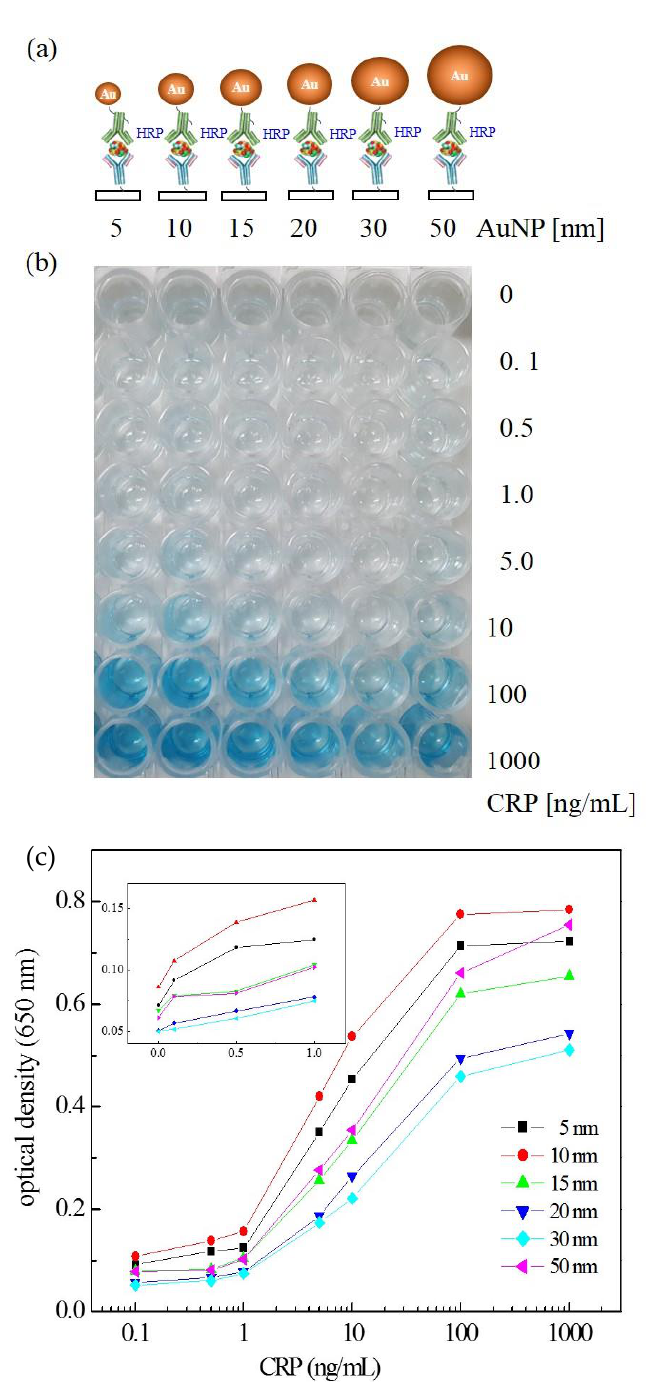
Figure 1. ( a ) The schematic view of the sandwich ELISA using AuNP • antiCRP-HRP with varying diameters of the AuNPs involved, ( b ) the picture of 96-well plate of the resulting ELISA produced based on the AuNP • antiCRP-HRPs, and ( c ) the plot of optical density and CRP concentration for the “AuNP ELISA” with varying diameter of